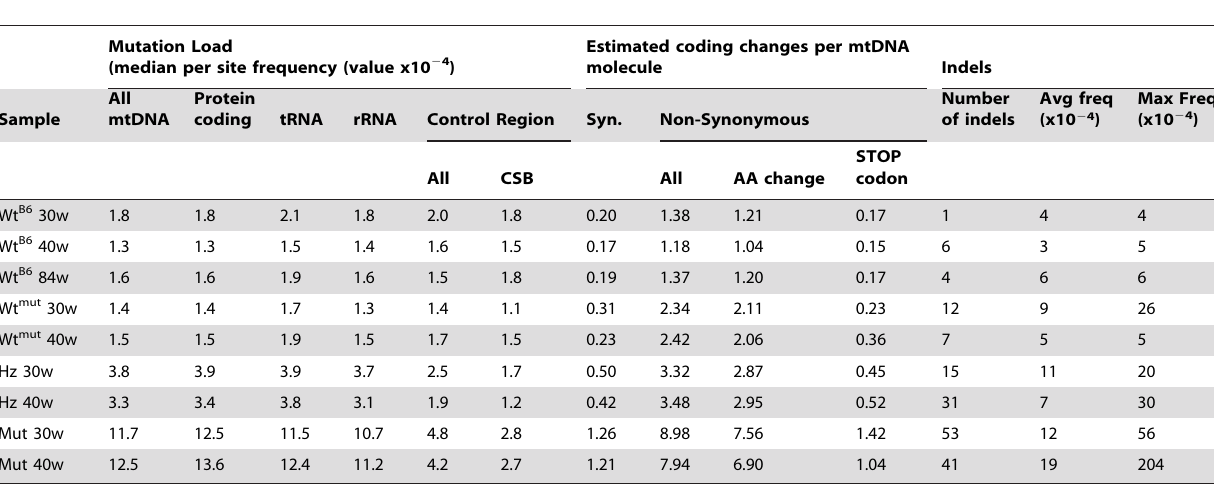
Table 1. Distribution of mutations in the mtDNA